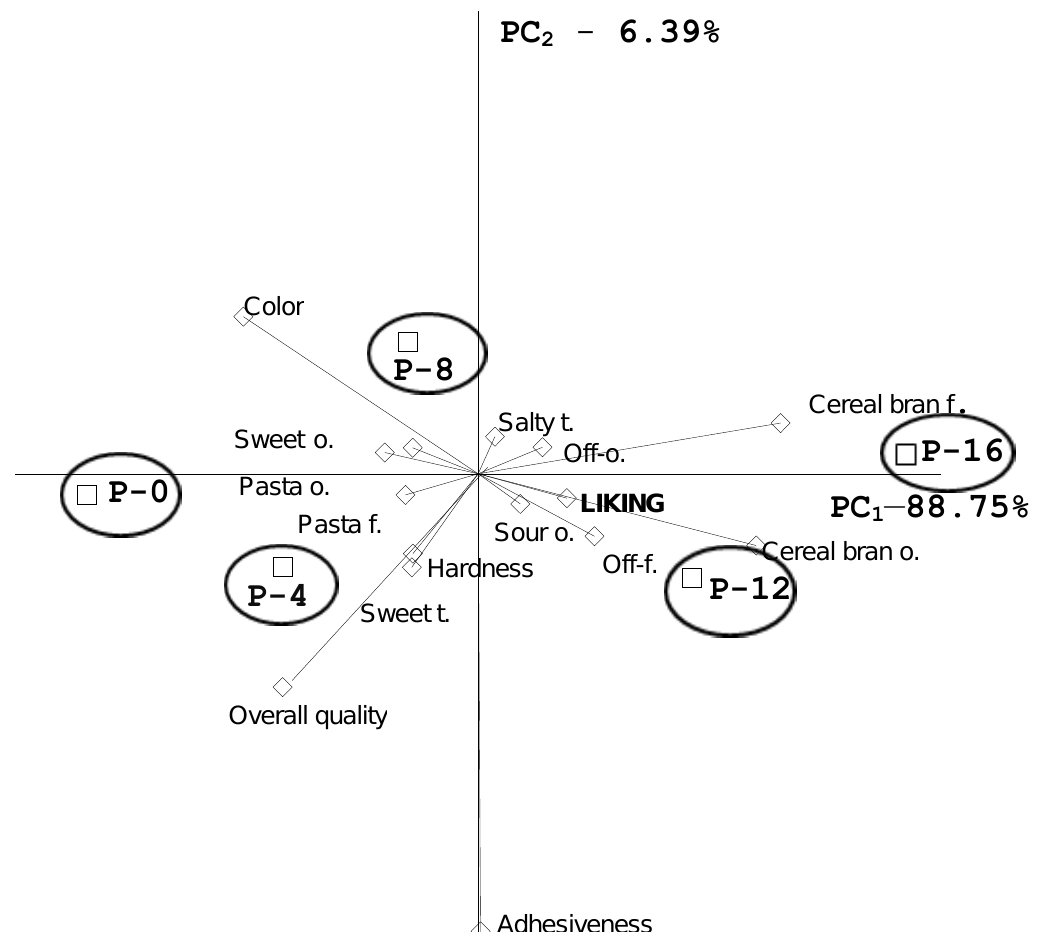
Figure 4. PCA (Principal Component Analysis) matrix of the mean sensory attributes obtained in the QDP (Quantitative Descriptive Profile) method for cooked pasta (P-0 — control sample, P-4, P-8, P-12, and P-16 — 4 – 16% oat β -glucan fiber powder addition); o. – odor, f. — flavor, t. — taste.